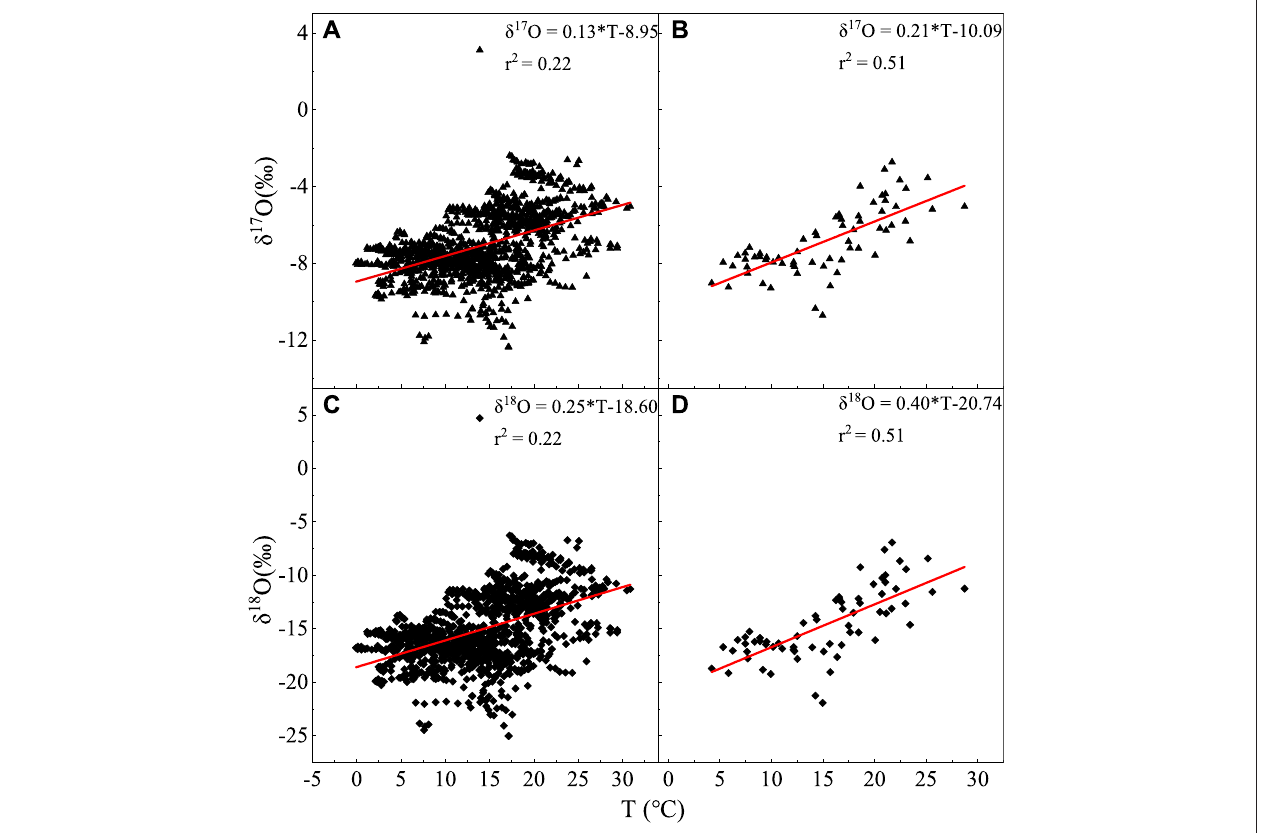
FIGURE6| Relationshipbetween δ 17 Oand δ 18 Oandtemperaturechangesondailyandmonthlyscales,with (A) δ 17 Oanddailyscale, (B) δ 17 Oandmonthlyscale, (C) δ 18 O and daily scale, and (D) δ 18 O and monthly